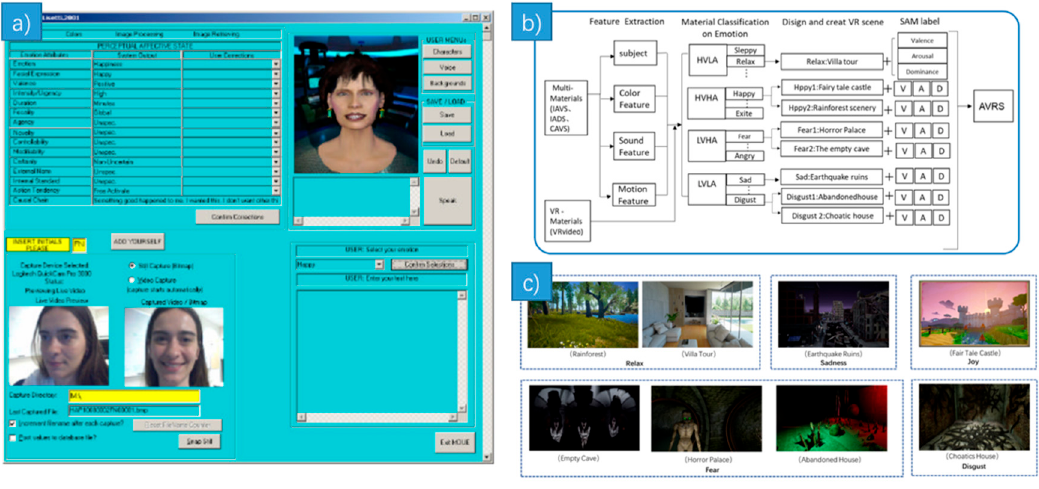
Figure 4. ( a ) MAUI—Multimodal Affective User Interface; ( b ) Framework of AVRS; ( c ) VR scenes cut show.